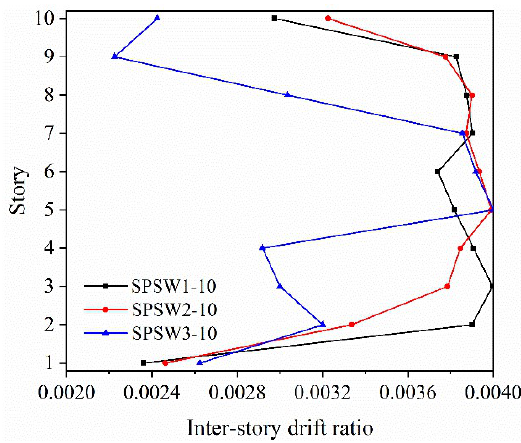
Figure 13. Inter-story drift ratio for optimum designs of 10-story steel frame.